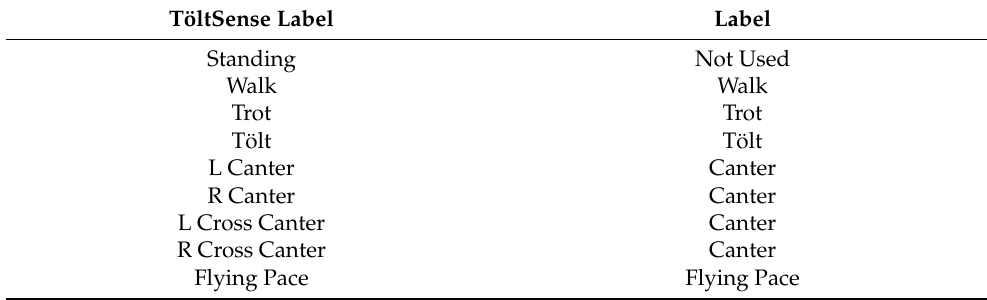
Table 2. Mapping from the TöltSense labels to the ones used in this study. TöltSense Label Label Standing Not Used